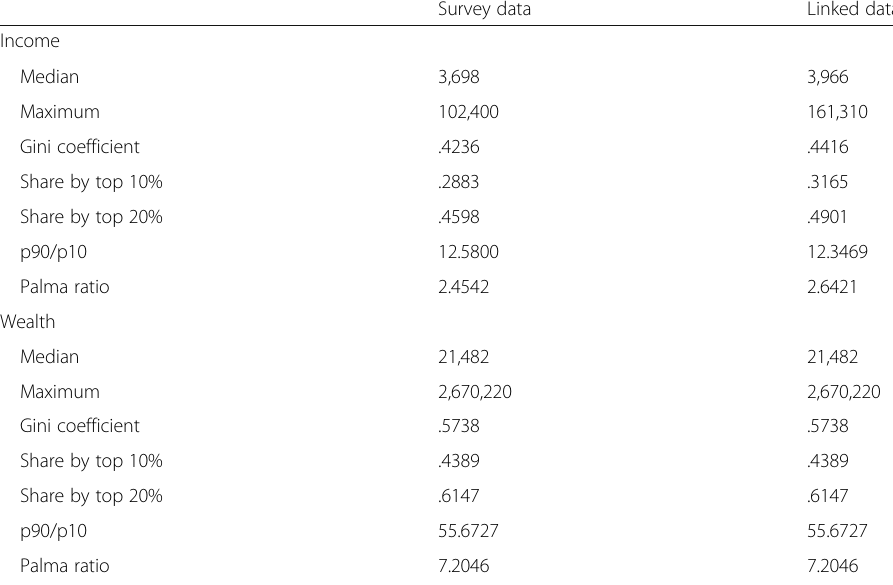
Table 1 Measurement of income inequality and wealth inequality, 2017 Survey data Linked